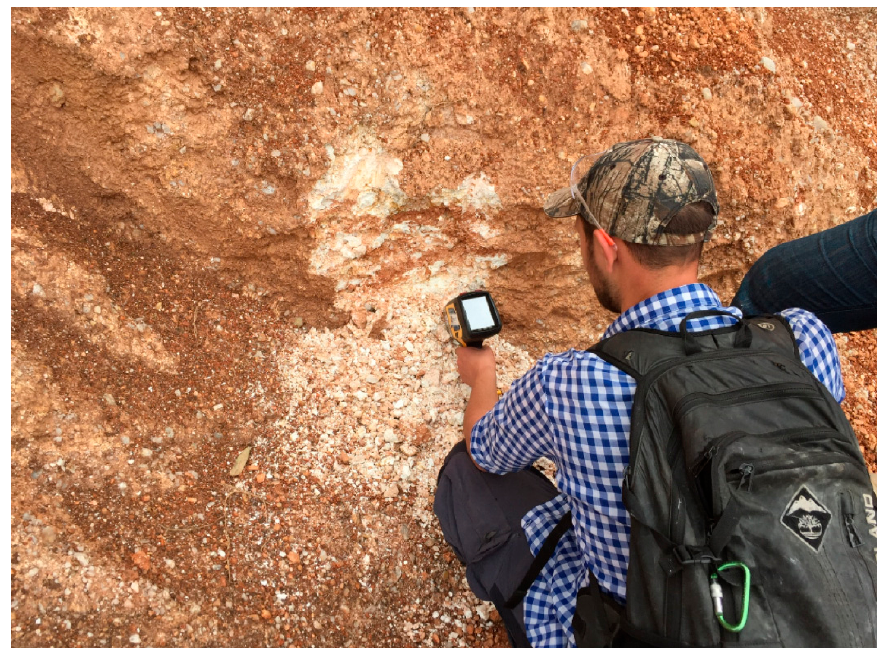
Figure 5. Portable XRF (pXRF) equipment is a valuable screening tool in grassroots LCT pegmatite exploration. At Ruhanga (Rwanda), B horizon soils overlying kaolinised LCT pegmatite contained large flakes of muscovite. Analysis by pXRF provided K/Rb values of 4.8, indicating highly fractionated bedrock and therefore a possible target [45].